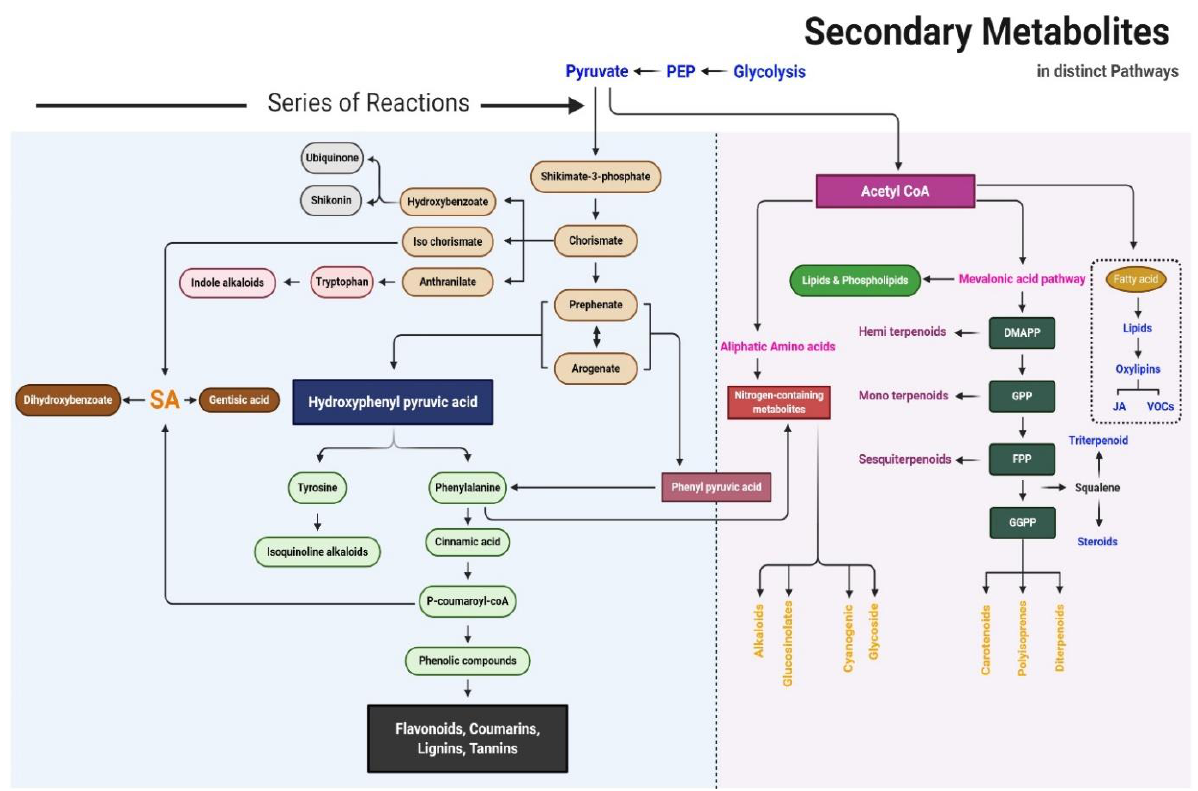
Figure 2. Schematic of the secondary metabolite biosynthesis pathway.